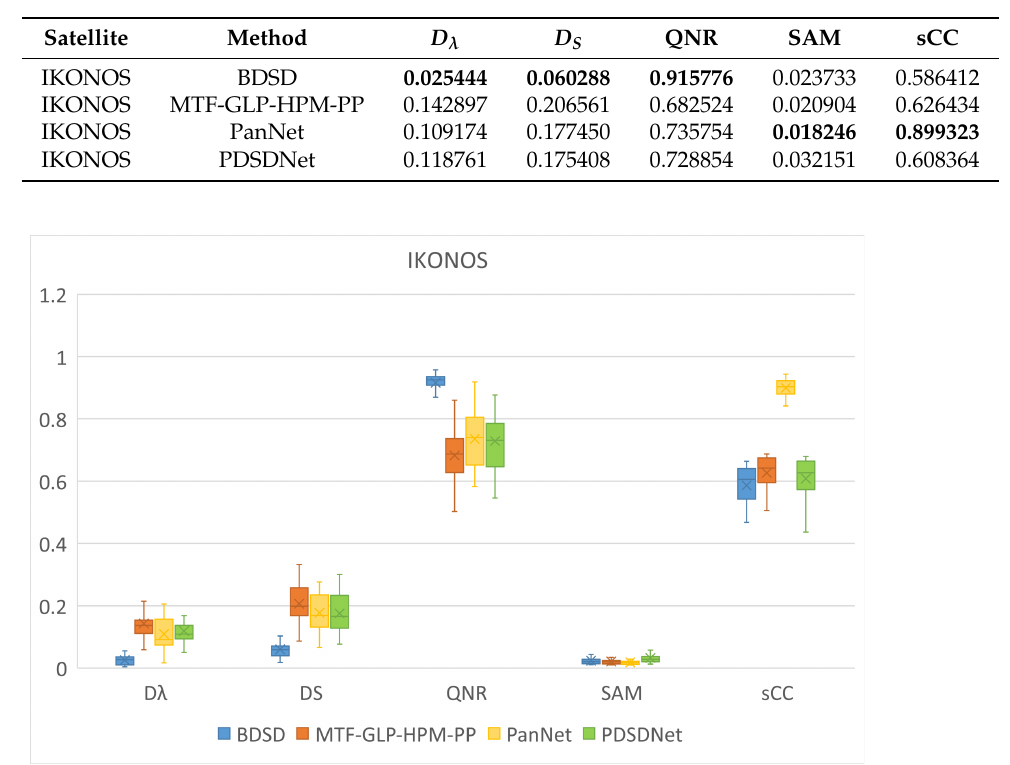
Figure 6. Quality indexes of results of BDSD, MTF-GLP-HPM-PP, PanNet, and PDSDNet. The boxplot represents the dispersion of the data through maximum, minimum, median, upper and lower quartiles of quality indexes of test images. The length of the box shows the interquartile range (IQR), and the smaller range means more concentrated data. The line’s location in the box is the median, which represents the general state of the data. Moreover, the ‘ × ’ is the position of mean value corresponds to the value in Table 4. The upper and lower edge line means maximum and